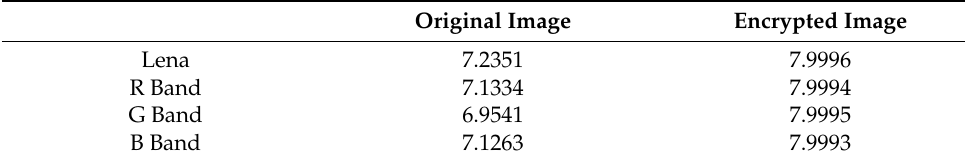
Table 6. Entropy evaluations of the employed